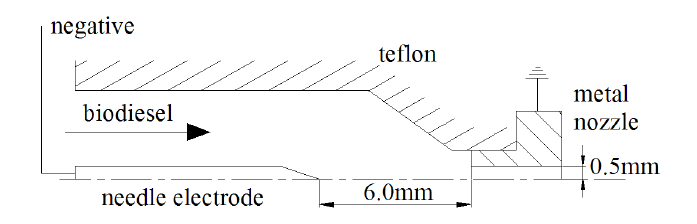
Figure 7. Schematic of the atomizer nozzle.